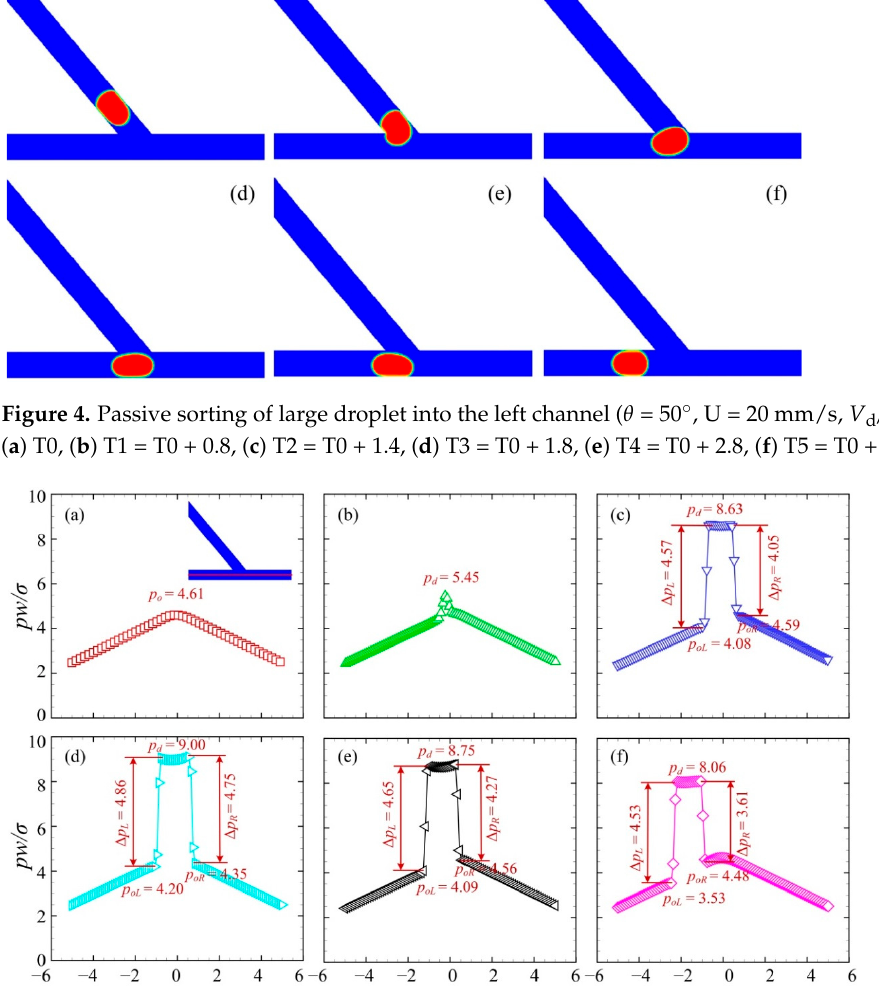
Figure 6. Passive sorting of small droplet into the right channel ( θ = 50°, U = 20 mm/s, V d /w 3 = 0.6). ( a ) T0, ( b ) T1 = T0 + 0.6, ( c ) T2 = T0 + 1, ( d ) T3 = T0 + 1.6, ( e ) T4 = T0 + 2.8, ( f ) T5 = T0 + 3.6.